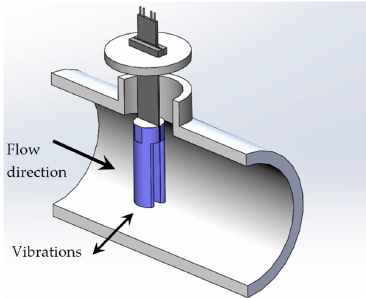
Figure 2. Energy harvester assembled inside a water pipe with the U-shaped geometry as the oscillating body (not to scale).